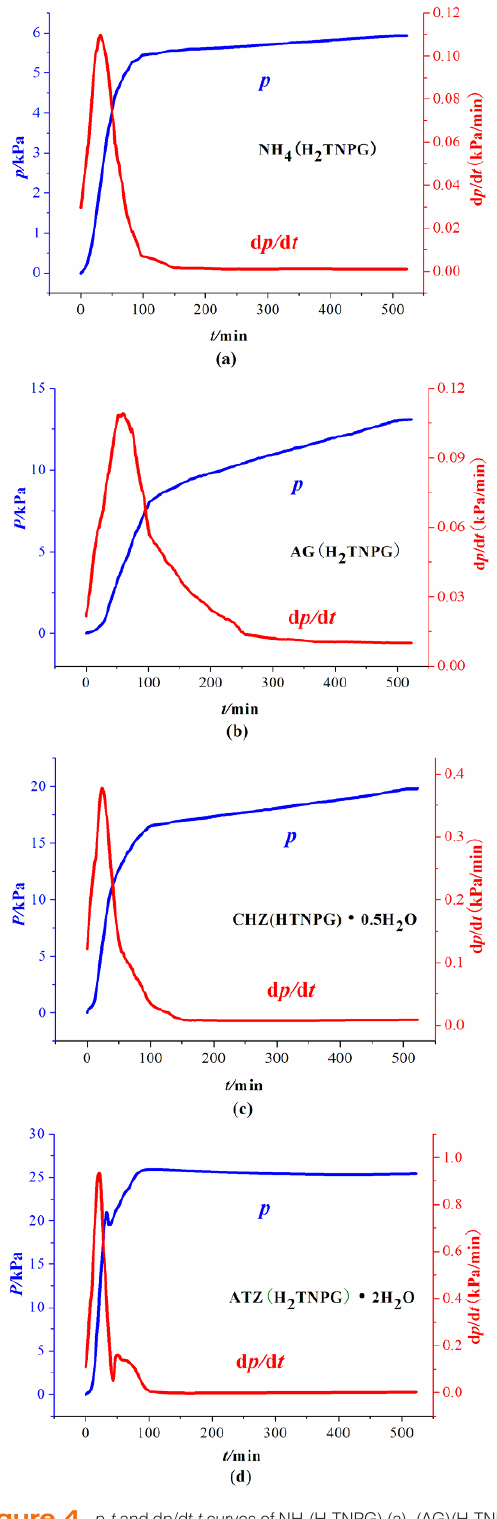
(H TNPG) (a), (AG)(H 4 2